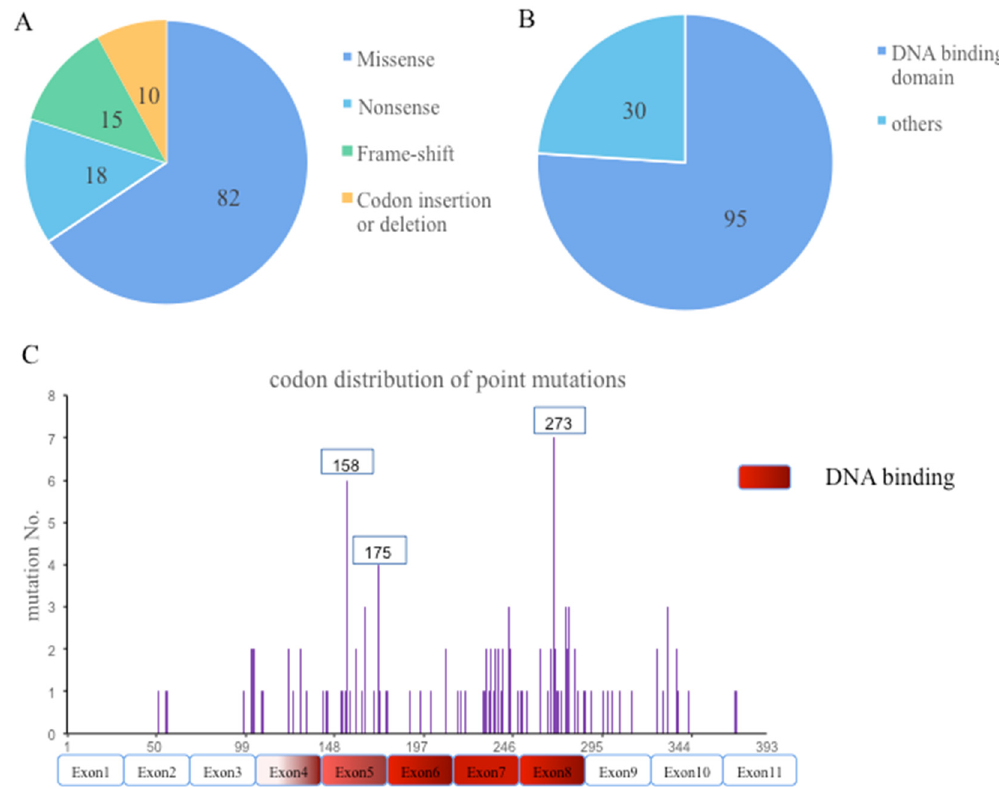
Figure 3. “Technical” types ( A ), cluster of domains ( B ), and codon distribution ( C ) of TP53 mutation in 109 patients.